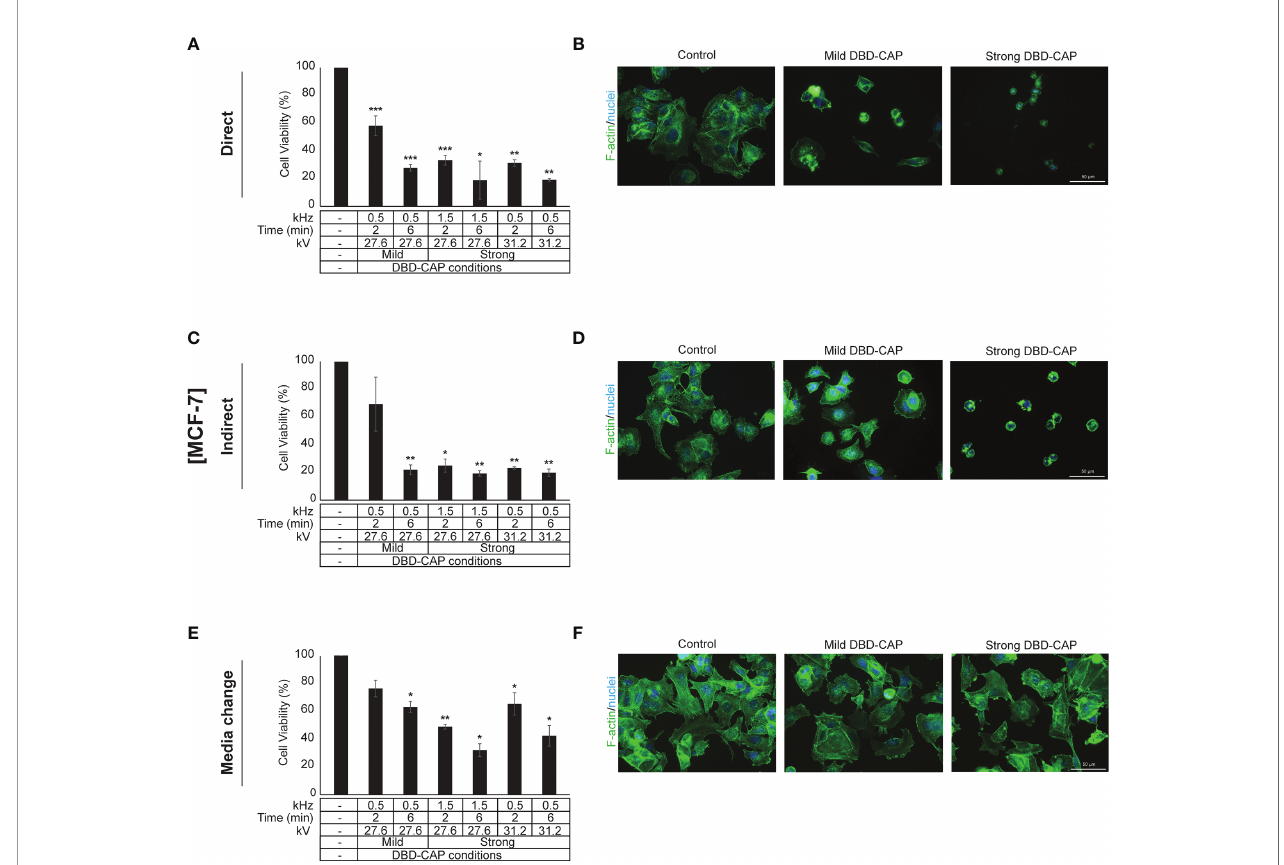
FIGURE 5 | DBD-CAP suppresses MCF-7 (ER+, low metastatic) breast cancer cell growth. (A , C , E) Assessment of % cell survival 24 h after treatment with mild (0.5 kHz/27.6 kV) or strong (1.5 kHz/27.6 kV or 0.5 kHz/31.2 kV) DBD-CAP (direct, indirect, media change) for 2 and 6 min. The values represent the mean ± SD of 3 (at least) independent experiments. Asterisks illustrate signi fi cant differences of the different treatment conditions compared to untreated (control) cells (* p < 0.05, ** p < 0.01, *** p < 0.001). (B, D, F) Cell morphology after mild (0.5 kHz/27.6 kV) or strong (0.5 kHz/31.2 kV) DBD-CAP treatment for 2 min. Scale bars, 50 µm. Representative immuno fl uorescence images are shown ( F-actin , green; nuclei ,